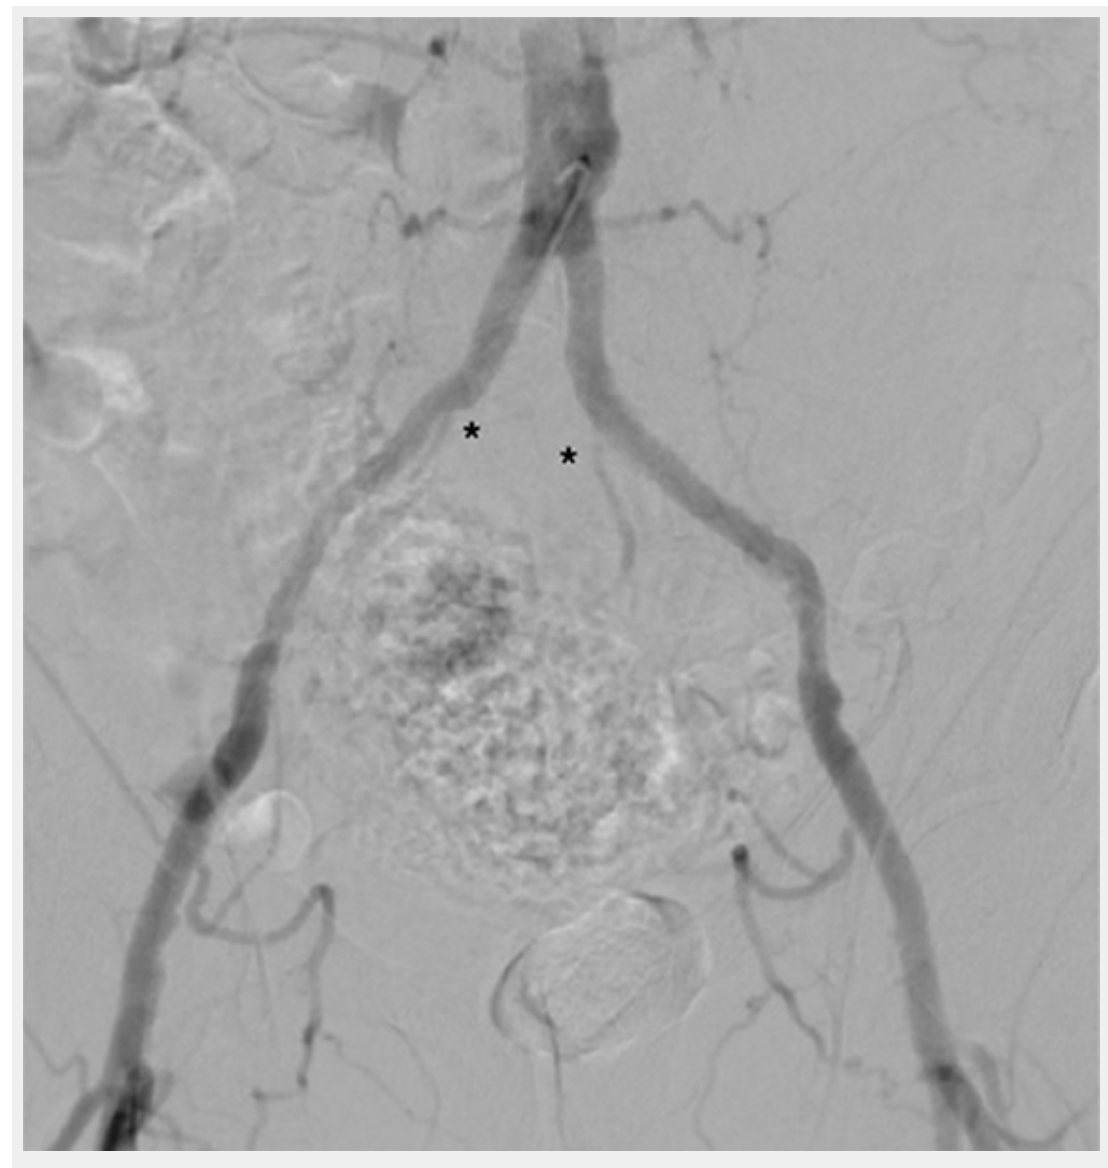
Figure 3 Sub-total occlusion of both hypogastric arteries (*) in a patient with cardiovascular risk factors and erectile